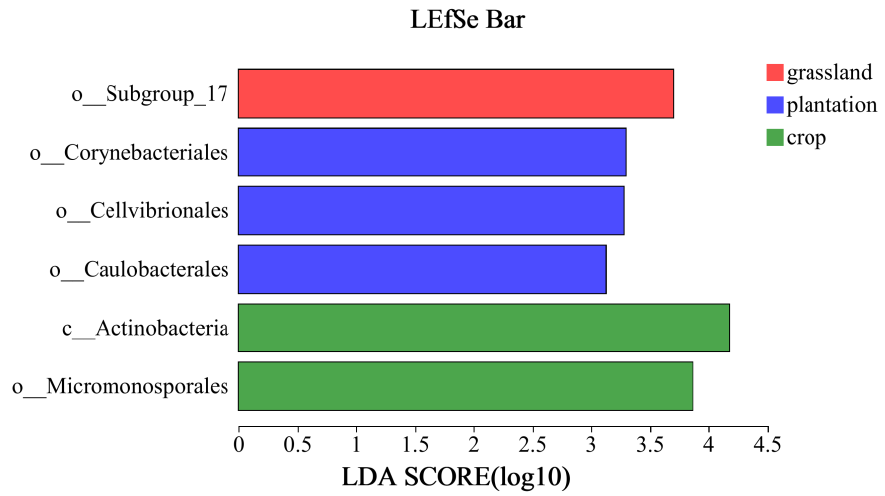
Figure 8. Histogram of LDA value distribution of soil bacterial species in three karst land-use types.